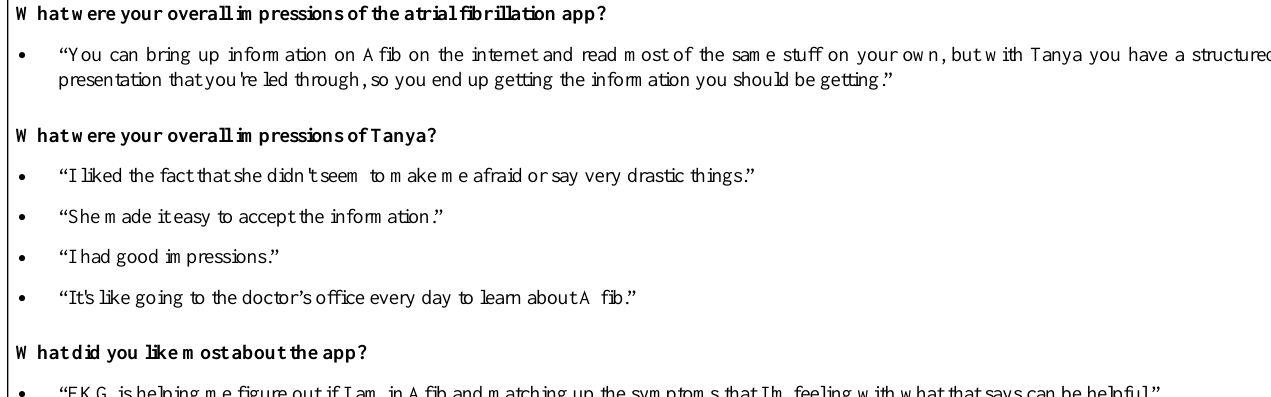
Textbox 2. Representative responses of pilot trial participants randomized to the intervention